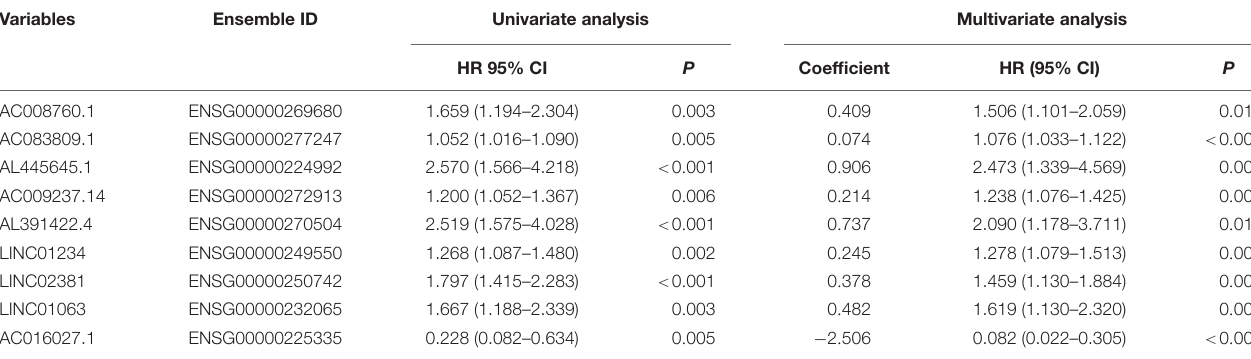
TABLE 2 | Univariate and multivariate Cox regression analyses of nine immune-related lncRNAs in the training cohort. Variables Ensemble ID Univariate analysis Multivariate